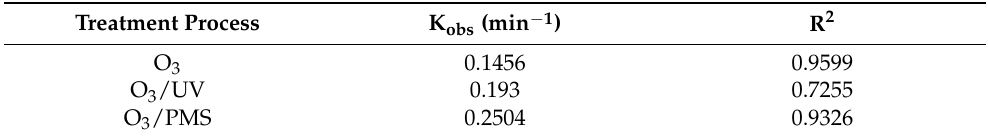
Table 2. Pseudo-first-order rate constant of SDZ degradation by O 3 , O 3 /UV, and O 3 /PMS